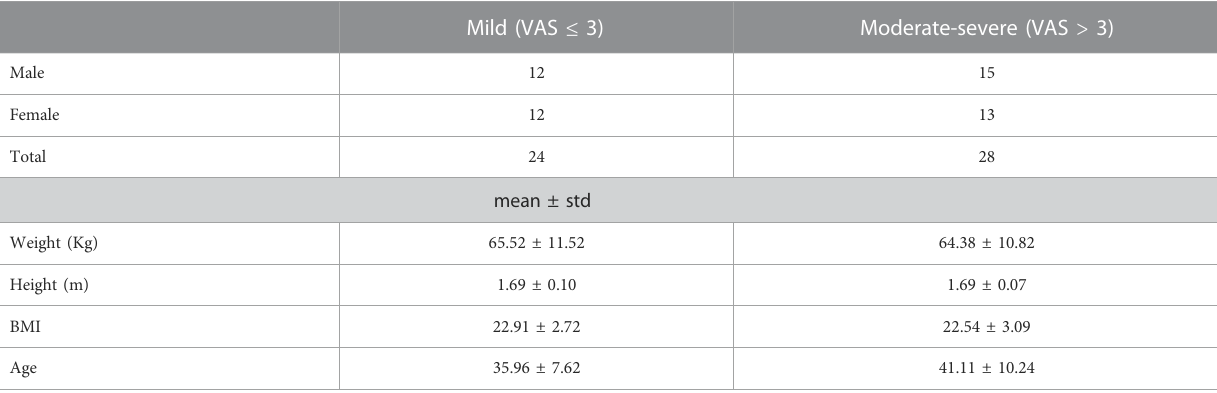
TABLE 1 Descriptive statistics from the data.